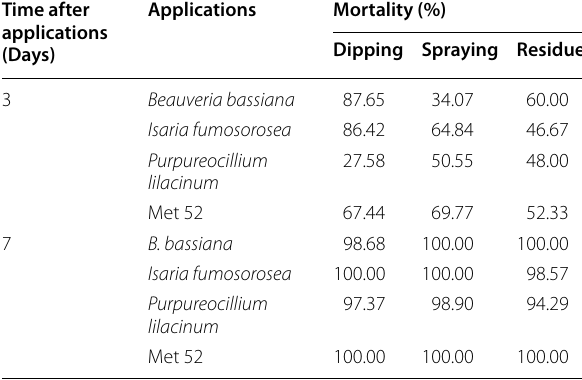
Table 1 Efficacy of entomopathogenic fungi against third instar Tuta absoluta larvae, 3 and 7 days after applications by three methods in petri dish